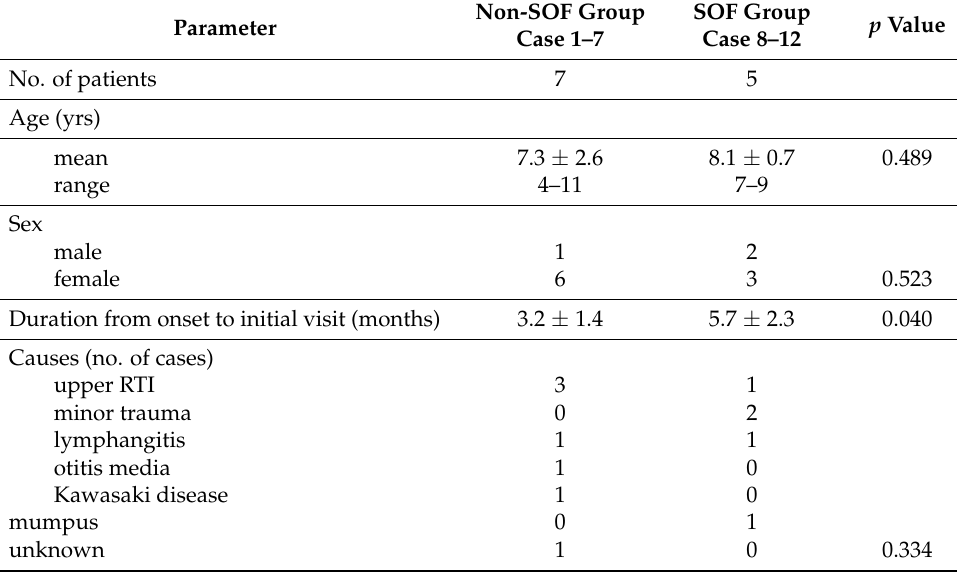
Table 2. Comparison of clinical and imaging